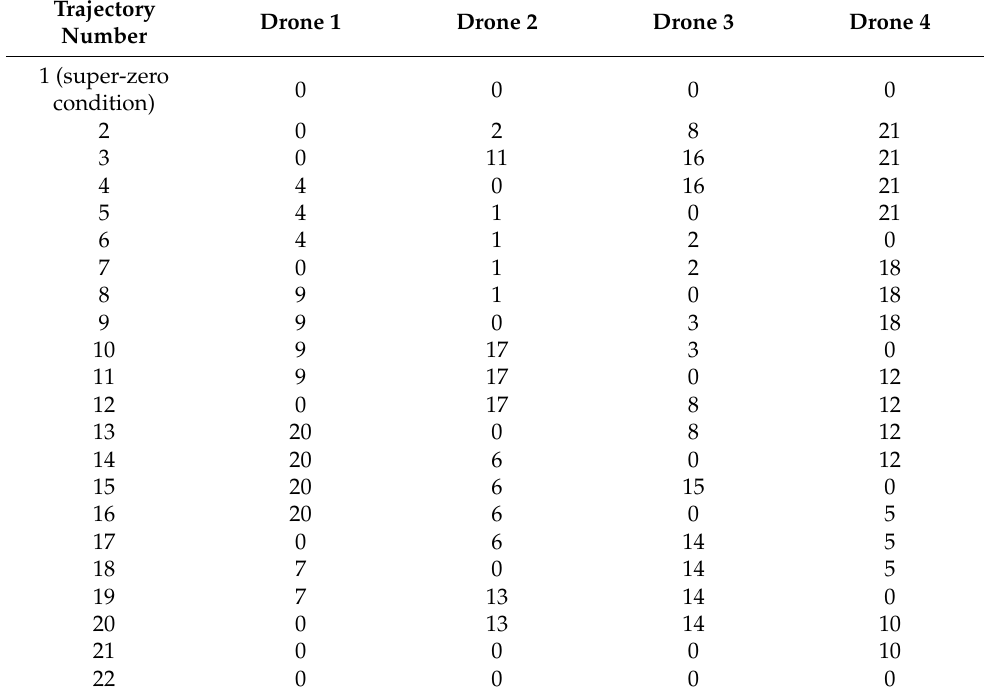
Table 2. Assigned tasks for the UAV fleet.